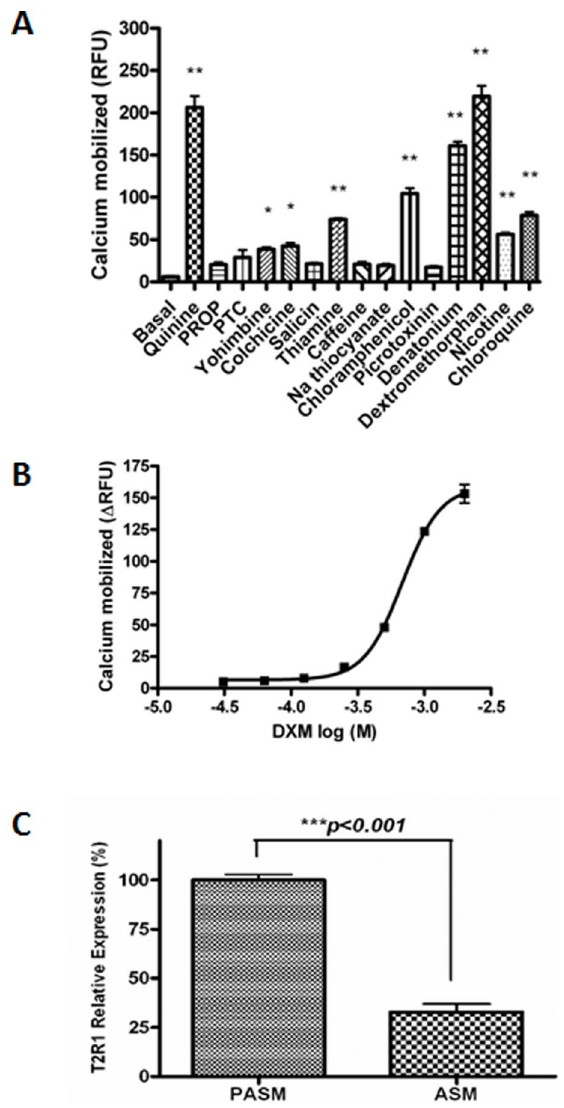
Figure 2. Functional response of hPASMCs to different bitter agonists. A . Bitter compounds of diverse structures cause increase in intracellular calcium in primary cultures of hPASMCs. Intracellular calcium [Ca 2 + ] i responses to 1 mM yohimbine, 2 mM quinine, DXM and nicotine, 3 mM chloramphenicol and picrotoxinin, 5 mM colchicine, thiamine, caffeine, PTC, PROP and sodium thiocyanate, and 10 mM denatonium benzoate, salicin and chloroquine. Results are means 6 SEM from n=5 done in triplicate, except for salicin and caffeine (n=4). *p , 0.05 vs control and **p , 0.01 vs control. B . Concentration dependent changes in [Ca 2 + ] i of hPASMCs expressing endogenous T2R1 induced by exogenous bitter agonist DXM (log M). Data were collected from five independent experiments carried out in triplicate. For the calculation of dose response curve, signals of 10–15 wells receiving the same concentrations of same test substances were averaged, and the fluorescence changes of corresponding unstimulated cells were subtracted. An EC 50 value of 676 6 90 m M for DXM in hPASMCs was calculated using Graph Pad Prism software. C . Relative expression levels of T2R1 in hPASMCs and hASMCs as determined by quantitative (q)-PCR. Relative expression of T2R1 in hASMCs was normalized to that in hPASMCs which was considered as 100%. Data presented are from five independent experiments done in triplicates. Results are normalized to expression of GAPDH. Values are plotted as mean 6 SEM. Relative expressions were computed using 2 2 D CT method. Statistical significance of T2R1 expression in hPASMCs was determined by student t -test, ***p , 0.001 vs T2R1in hASMCs. doi:10.1371/journal.pone.0110373.g002 PLOS ONE |